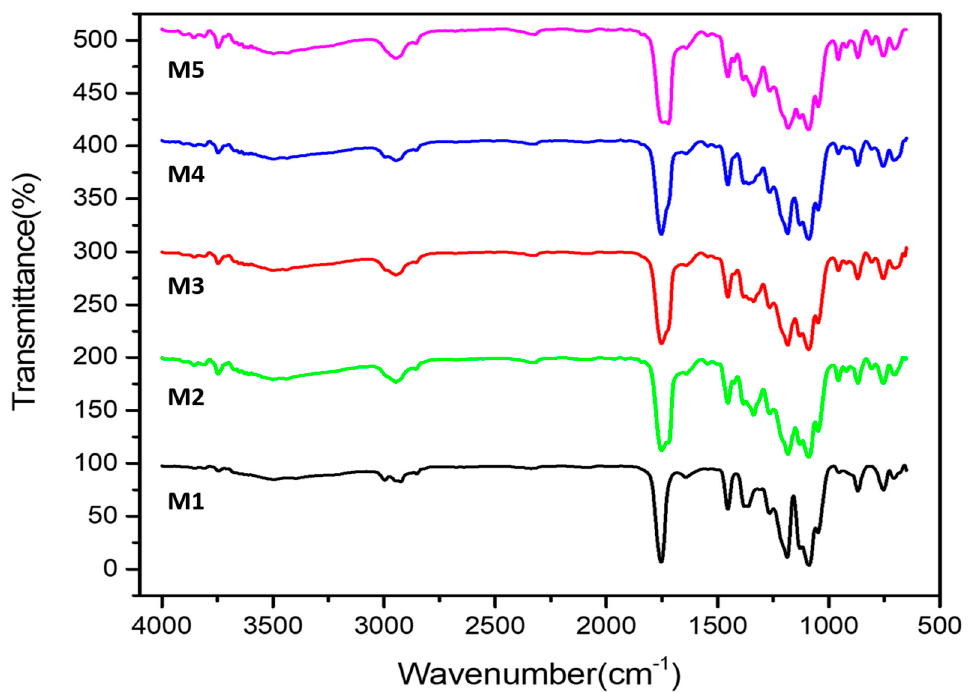
Figure 6. FTIR of PLA, PLA-PBS, and PLA-PBS-MCC composite films.